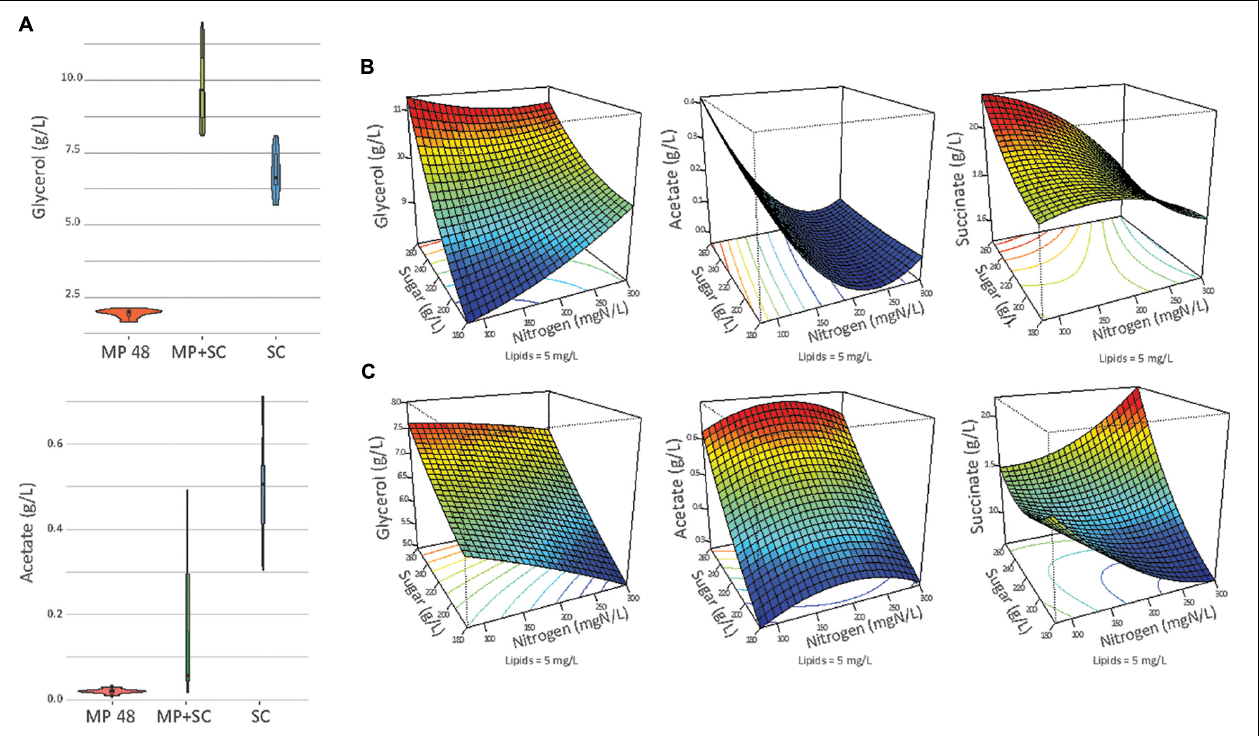
FIGURE 3 | (A) Production of glycerol and acetate in g/L at the end of fermentation (or at 48 h of fermentation if specified) in pure culture of S. cerevisiae (SC), under sequential inoculation at 48 h (MP 48 h) or at the end of the fermentation (MP + SC). At 48 h of fermentation, only M. pulcherrima is present in the medium. (B) Response surfaces of glycerol, acetate and succinate for fermentation under sequential inoculation (A) or in pure culture of S. cerevisiae (B) in relation to the variation of sugar, lipids and nitrogen. For all graphs, the lipid concentration is fixed at 5